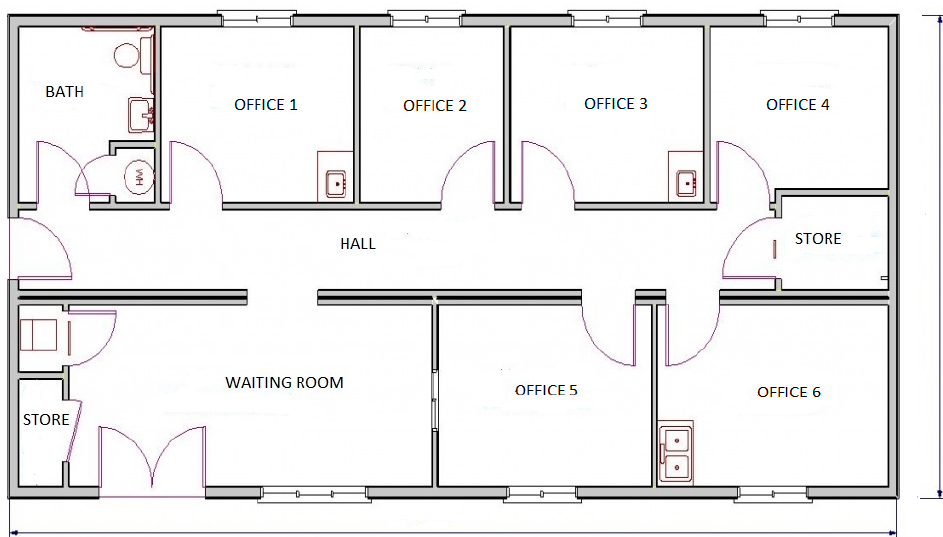
Figure 3. A floorplan of the office spaces being modelled.